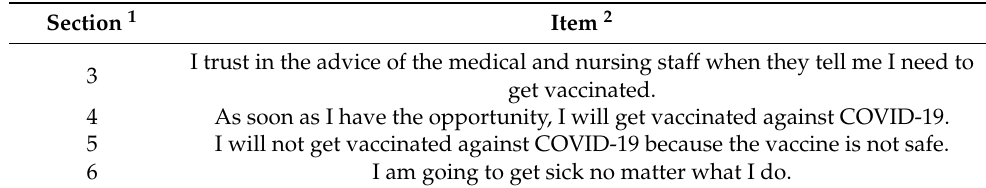
Table 3. Examples of the items by section of the final